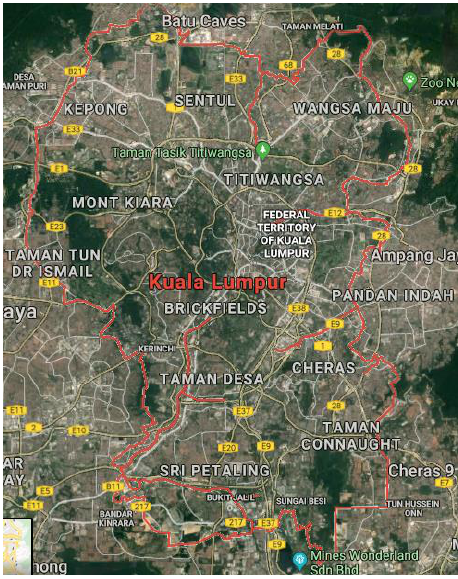
Figure 3: DBKL jurisdiction boundary